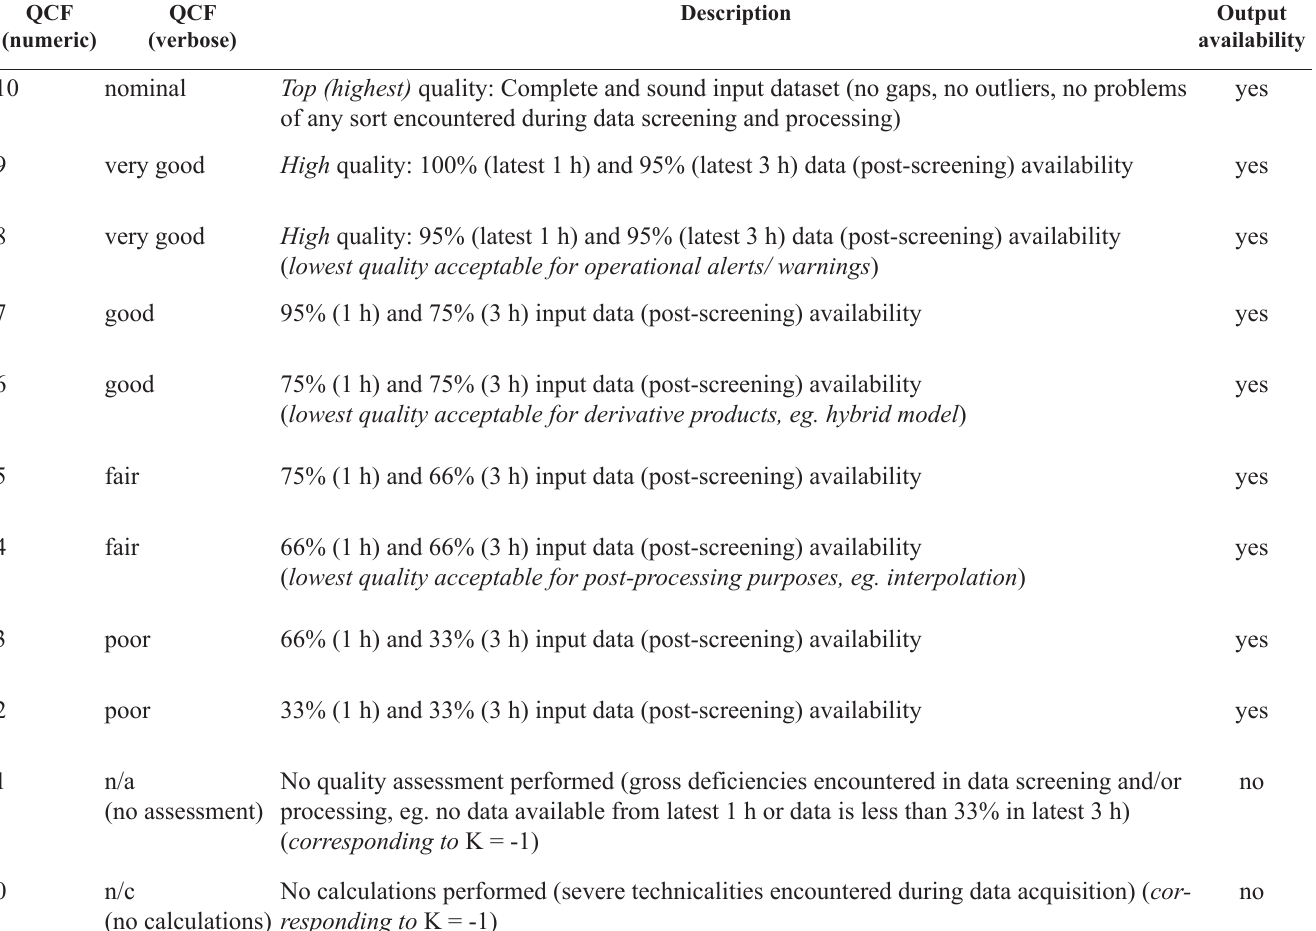
Table 2. Quality control flag (QCF) descriptions with respect to data input, screening and